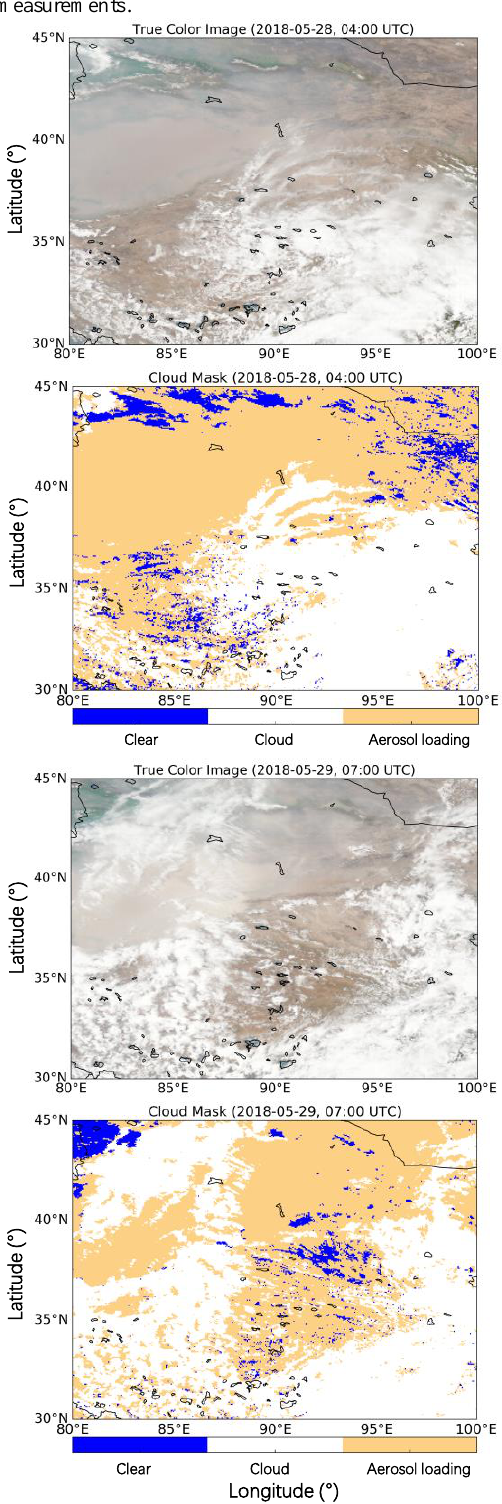
Figure 4 The aerosol loading detection over the Taklimakan and Gobi deserts for dust storms on 28 and 29 May